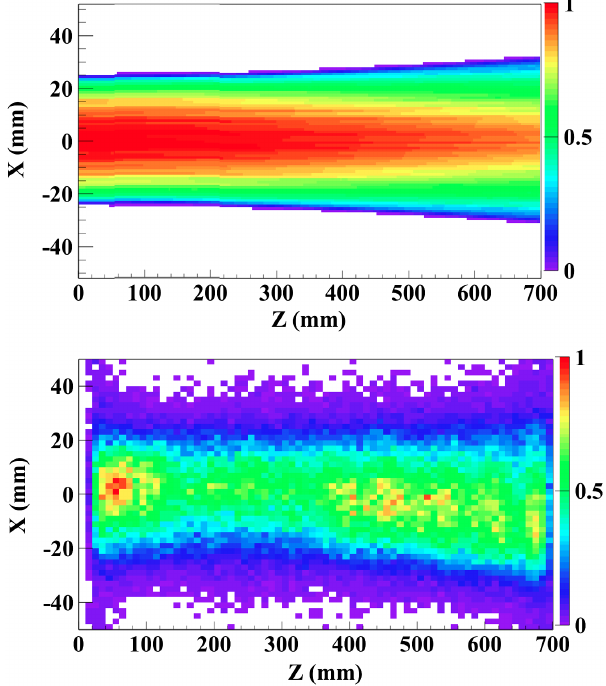
FIG. 3. Drift example: beam density (top) and secondary ion density (bottom).